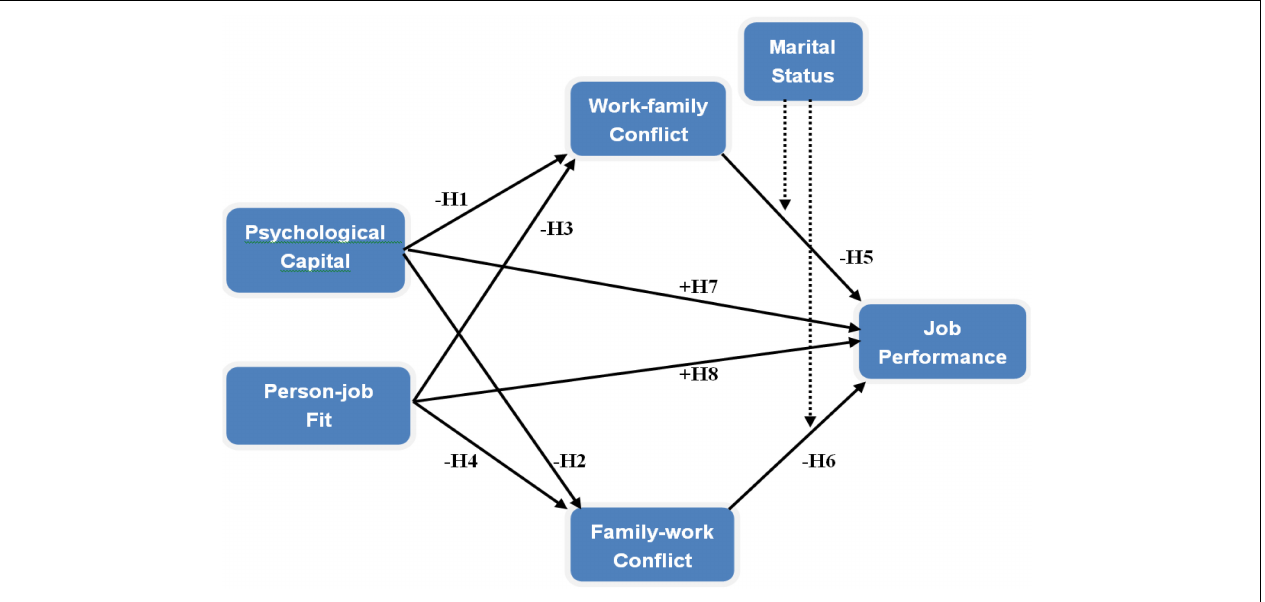
FIGURE 1 | Conceptual